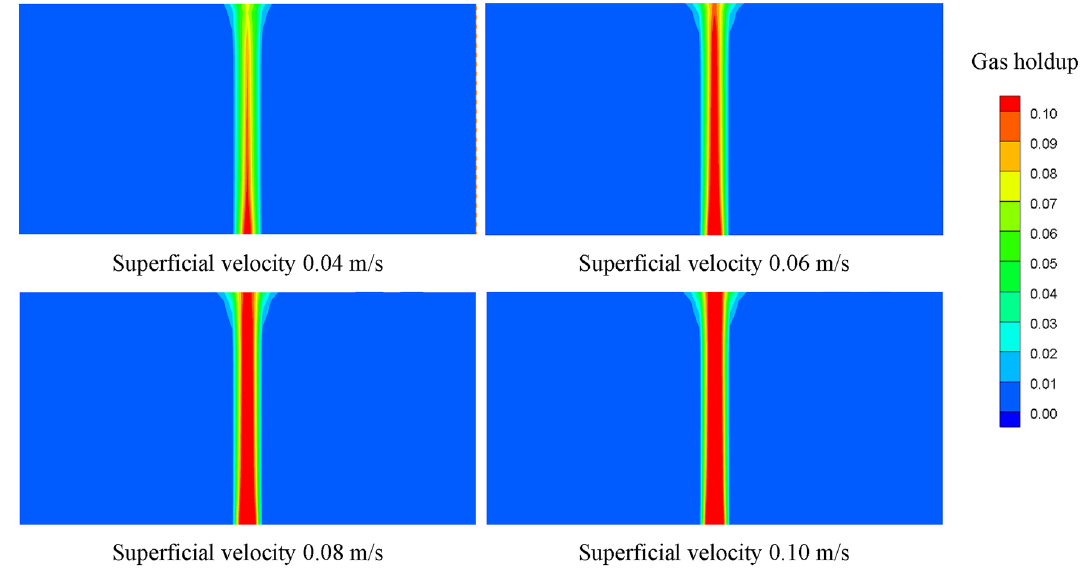
Figure 10. Gas holdup distributions at different superficial velocities.